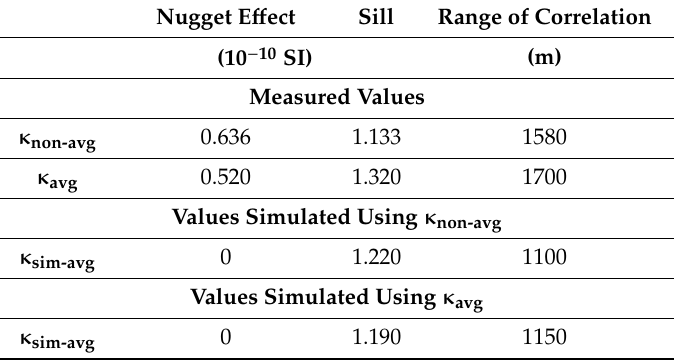
Table 2. Parameters of variogram spherical models measured and simulated κ